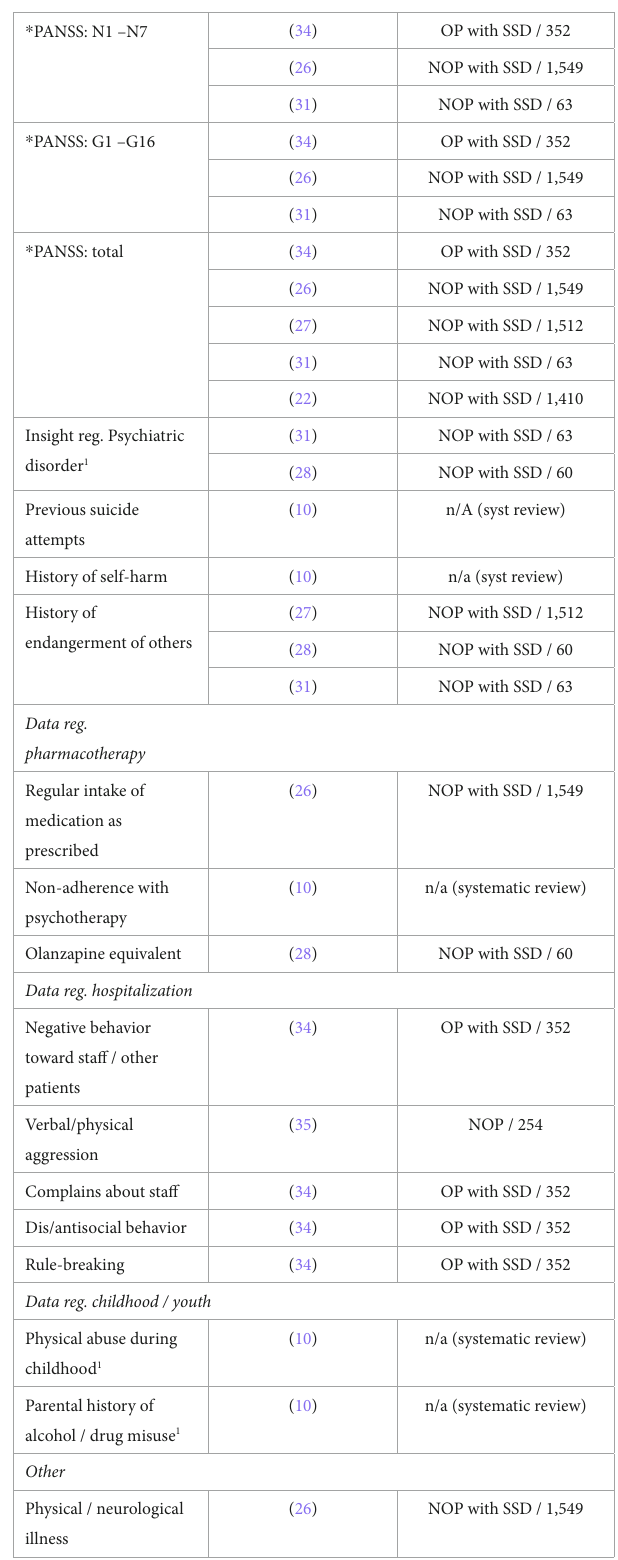
TABLE 1 Overview over selected predictor variables and their reference in previous literature. Variable in current study